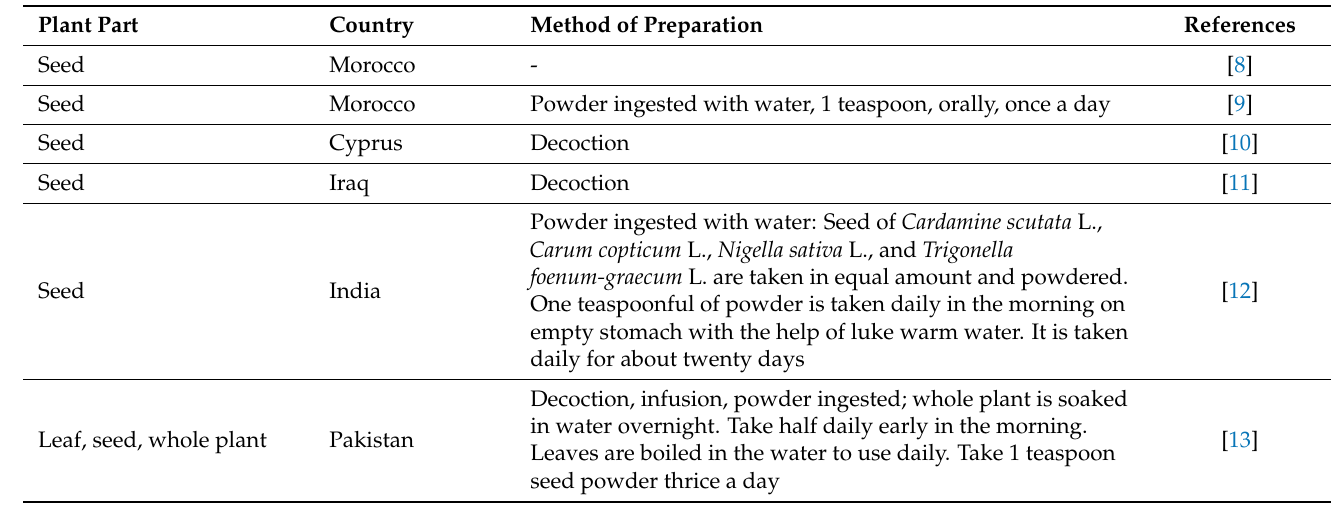
Table 1. Traditional uses of Nigella sativa L. in the management of